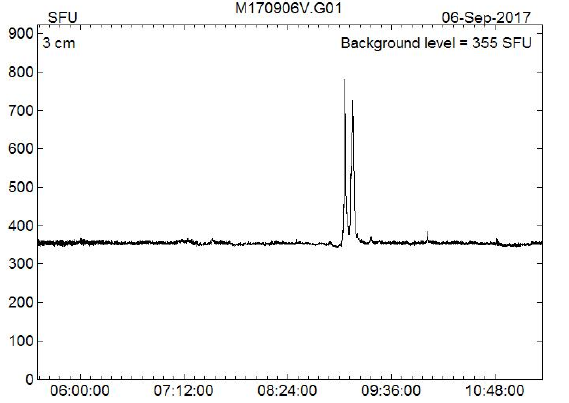
Fig. 2. Spectral flux of radio emission registered by RT-2 at a frequency of 10 GHz. The graph clearly shows that a strong radio burst occurred at 09:10 UT with a power of 691